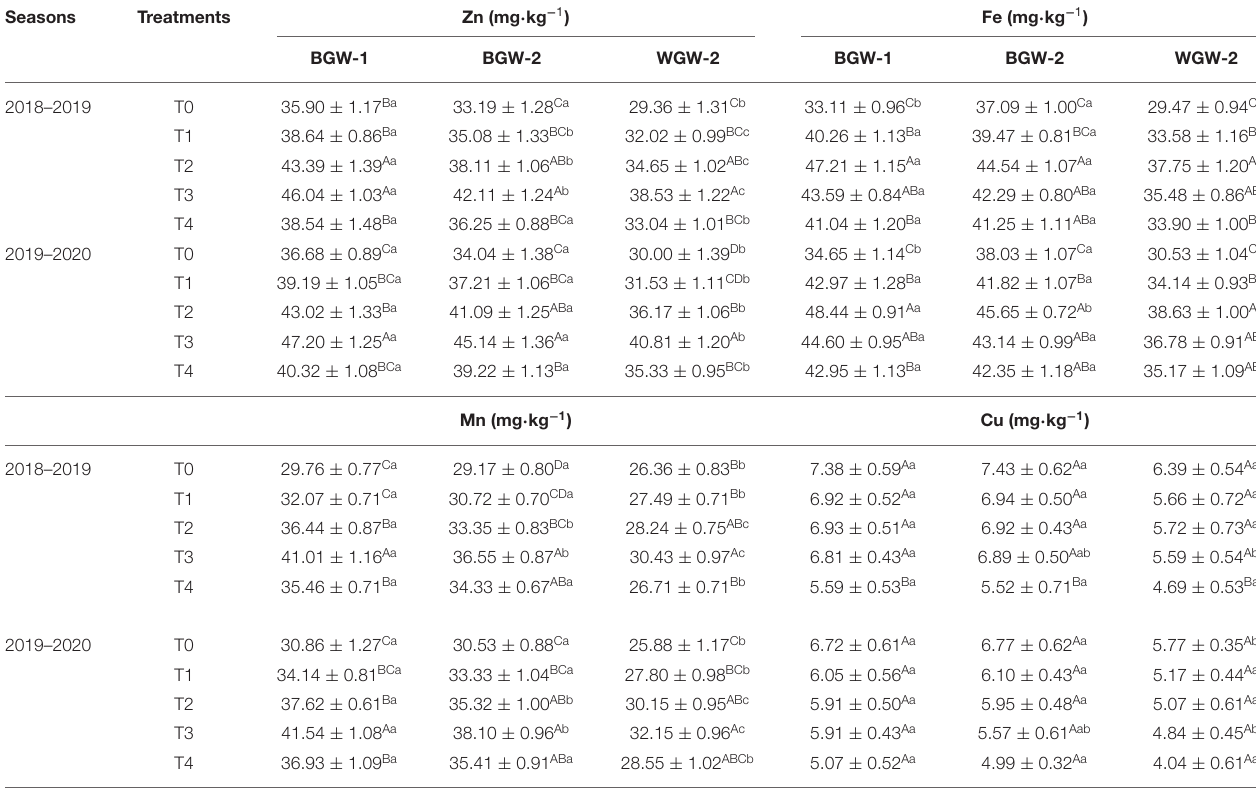
Different capital letters in the same column indicate a significant difference at α = 0.01. Different lowercase letters in the same row indicate a significant difference at α = 0.05. T0, no Se fertilizer; T1, 1,080 g · ha − 1 pure Se; T2, 2,160 g · ha − 1 pure Se; T3, 3,240 g · ha − 1 pure Se; T4, 4,320 g · ha − 1 pure Se; BGW-1, black-grained wheat genotype Xihei 88; BGW-2, black-grained wheat genotype Heidali; WGW-2, white-grained wheat cultivar Pubing